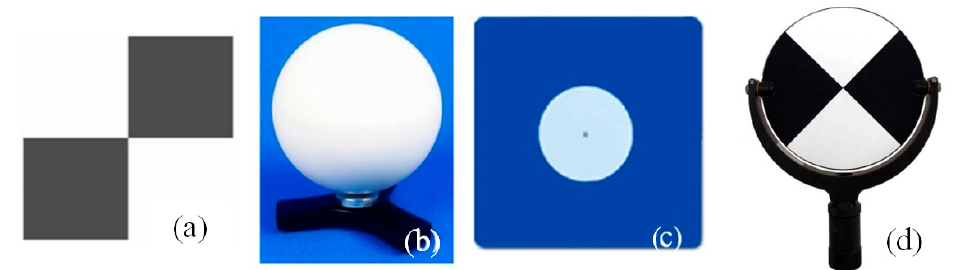
Figure 2. Typical targets: ( a ) checkerboard, ( b ) sphere, and ( c ) HDS target [5].